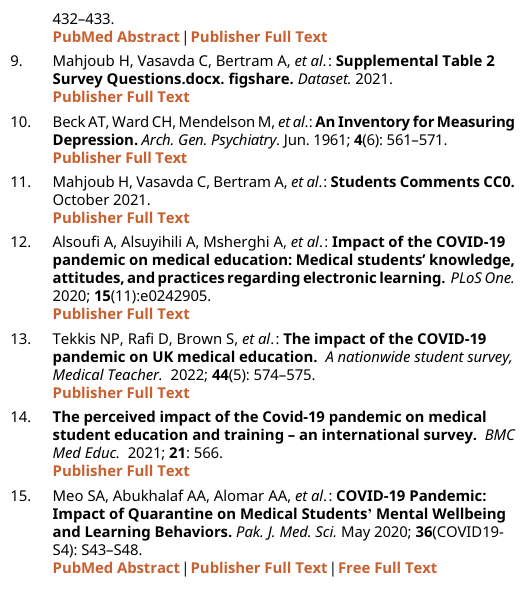
Figshare: The Perceived Impact of the COVID-19 Pandemic on Medical Students ’ Future Careers. DOI: https://doi.org/10.6084/m9.figshare.16879090.v1.